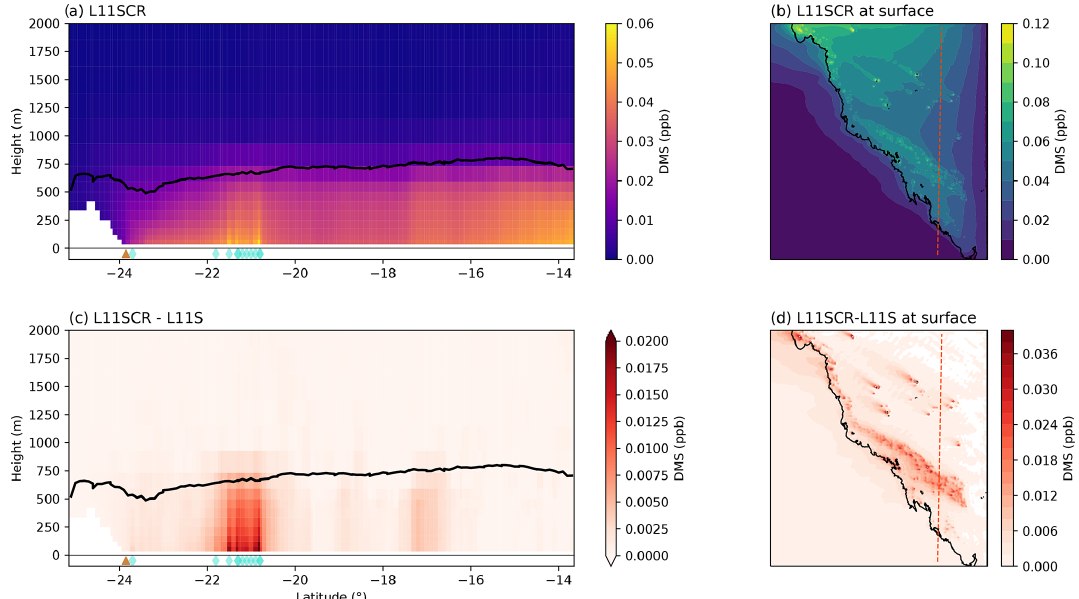
Figure 5. Vertical transects (a, c) and surface means (b, d) of DMS a for L11SCR (a, b) and the difference between L11SCR and L11S (c, d) . In (a) and (c) , the black line indicates the mean simulated boundary layer height, while the brown triangle shows the location of the Gladstone power station, and the blue diamonds show grid points within which coral reefs are found.